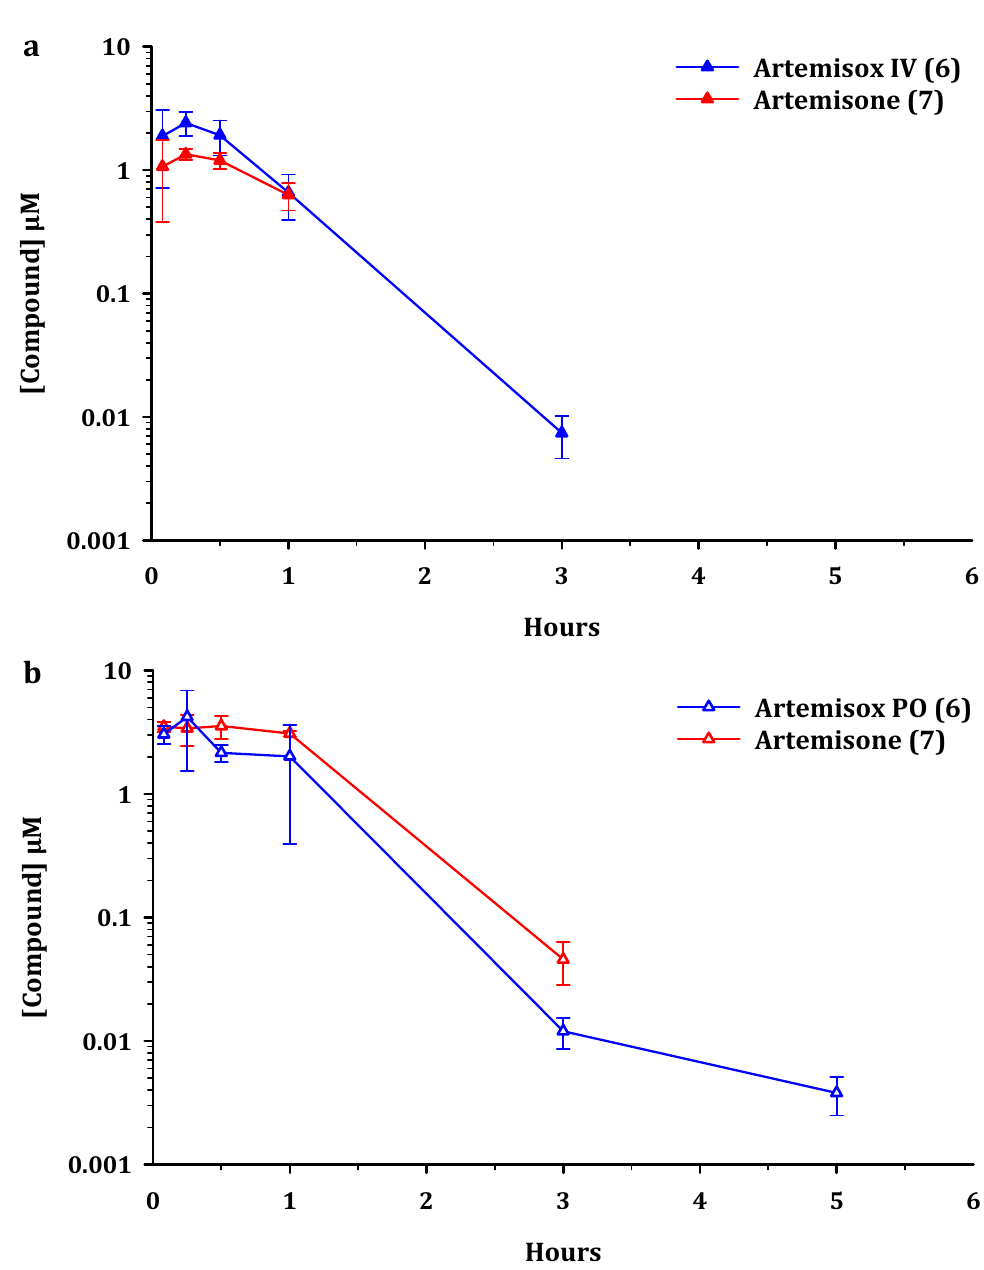
Figure 3. Circulating concentrations of artemisox 6 and its principal metabolite artemisone 7 after ( a ). intravenous ( iv ) administration of artemisox at 5 mg/kg to male C57/BL6 mice ( n = 3) and ( b ). after oral ( po ) administration at 50 mg/kg to male C57/BL6 mice ( n = 3). All results are presented as mean ± standard deviation.